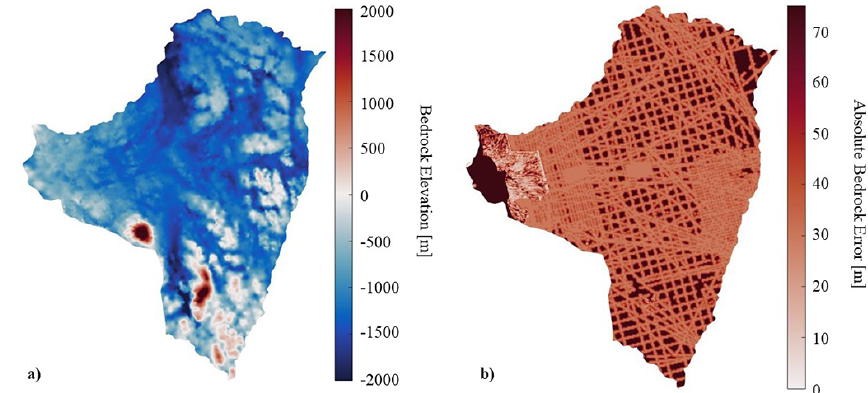
Figure 1. (a) Thwaites bedrock topography from BedMachine (Morlighem et al., 2020) is given with (b) its corresponding uncertainty (considered to represent 3 σ ) in the region. The data are interpolated onto our ISSM domain (later detailed) from its original grid map.